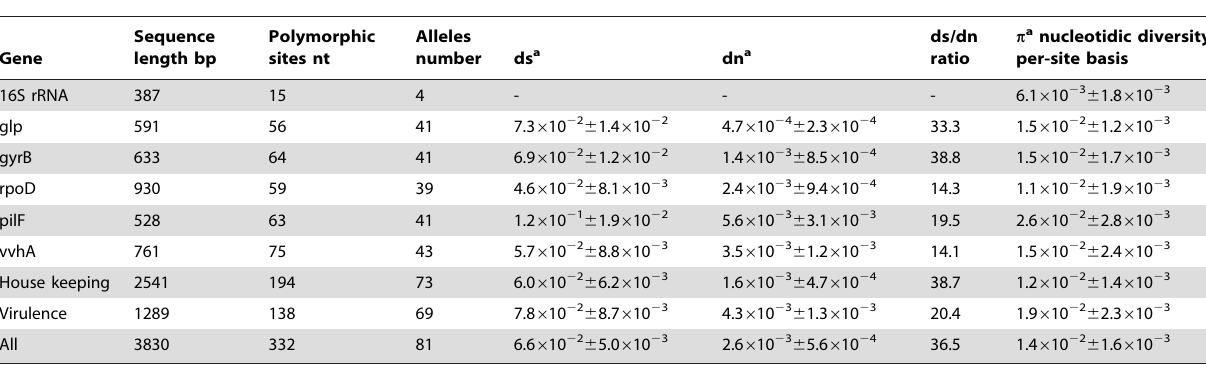
Table 2. Genetic diversity parameters for the genes used in the MLST.